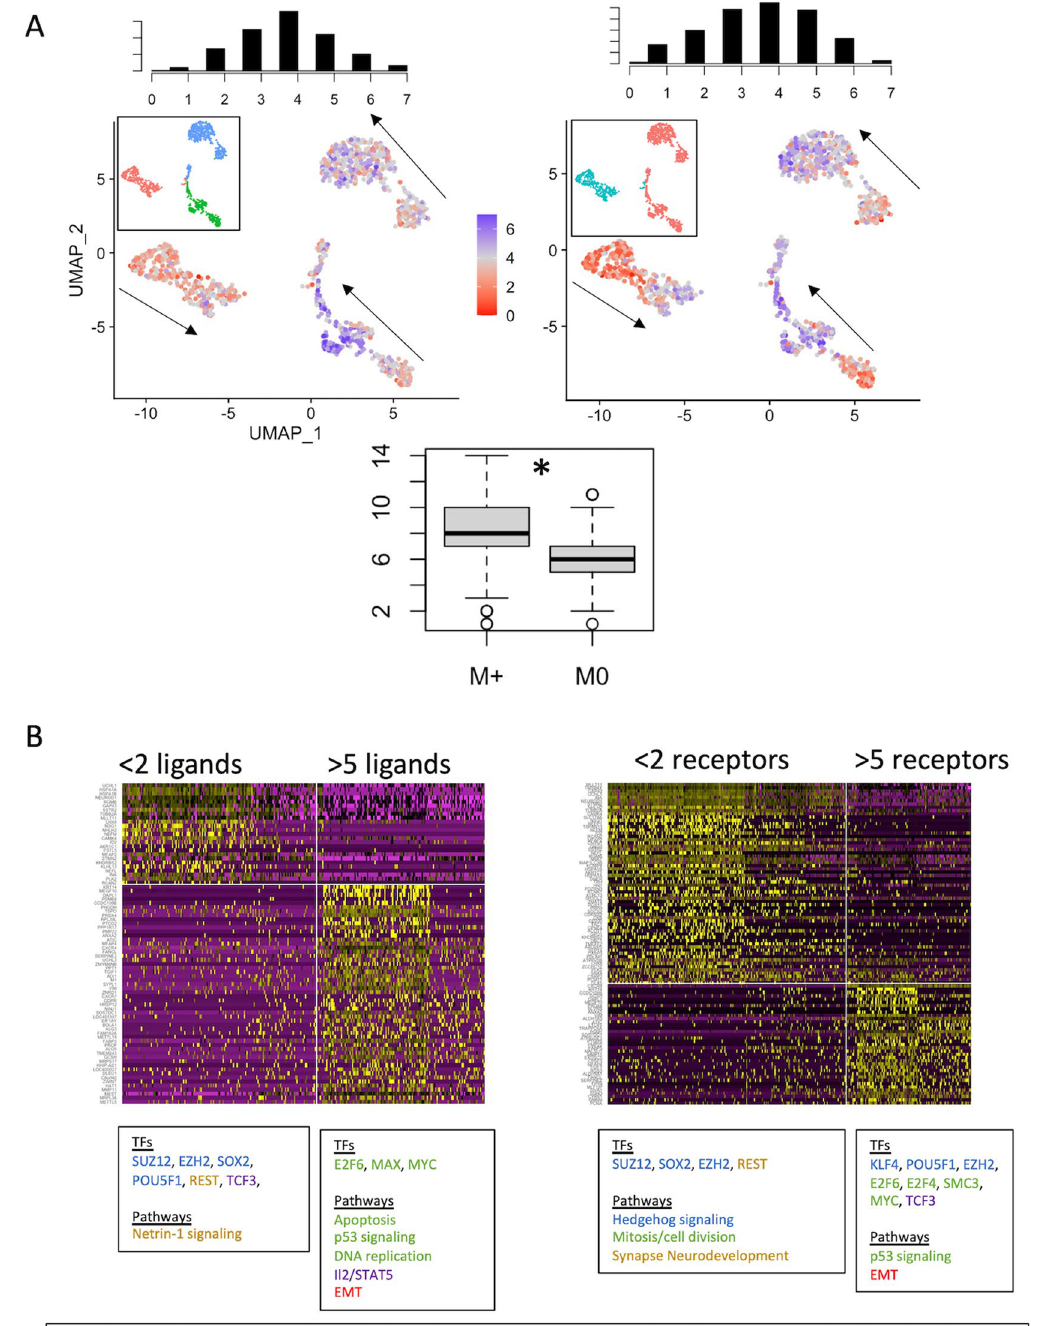
Figure 4. Characterization of stroma-associated single cell programs in SHH subtype. ( A ) UMAP plots of single cell transcriptomic data from SHH medulloblastoma. Cells are coloured based on the number of stroma- associated ligands (left) or receptors (right), as identified in Fig. 2. Above histograms represent the respective associated frequency distributions of ligand/receptor expression per cell. Inset images are the same UMAP plot, coloured by tumor ID (left) and metastatic status (right; red = metastasis present). We note apparent gradients from low to high density within each individual tumour, which is emphasized by arrows. ( B ) Markers associated with low vs. high number of ligands (left) or receptors (right) expressed (labeled above). Yellow indicates higher expression, while purple indicates low expression. Key enriched transcription factors (TFs) and pathways (only those with corrected p < 0.05) are labeled below and coloured by function. We note a predominance of developmental programs in cells with few stroma-associated ligands/receptors, while those which express more such receptors/ligands appear to be enriched in cell-cycling, EMT, and immune